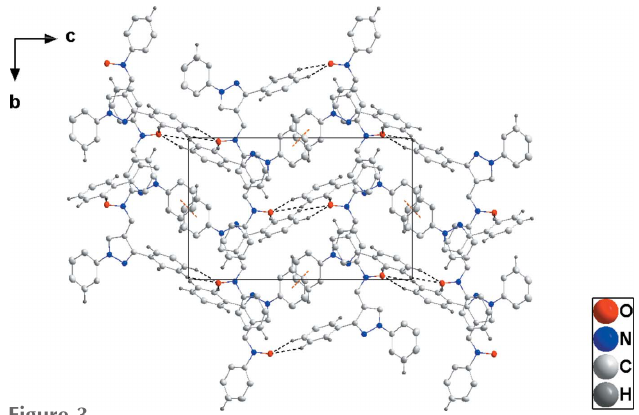
Figure 3 Packing viewed along the a -axis direction, with intermolecular inter- actions shown as depicted in Fig. 2.